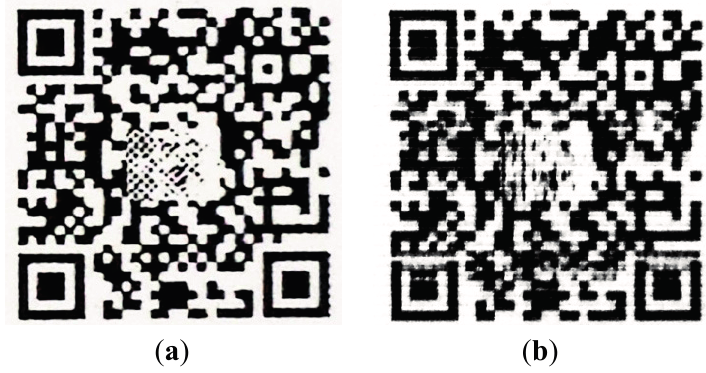
Figure 15. Anti-heating transfer quick response (QR) code. ( a ) Before heating; and ( b ) after heating.